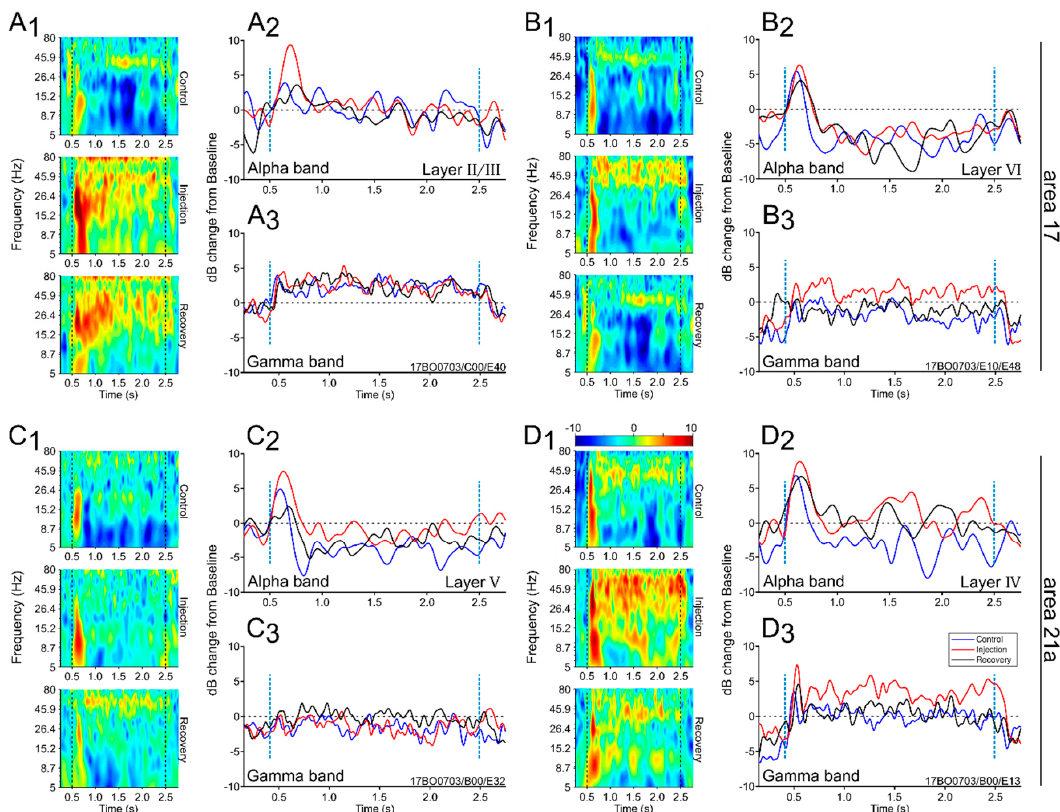
Figure 2. Oscillatory analysis for areas 17 and 21a recordings across experimental conditions. Wavelet analysis was used to calculate spectral estimates. (1) Time-frequency figures for representative samples. (2) Average time-frequency traces of alpha ranges. (3) Average time-frequency traces of gamma ranges for Ctr, Inj and Rec conditions. ( A ) Layer II/III recording from area 17. ( B ) Layer VI recording from area 17. ( C ) Layer V recording from area 21a. ( D ) Layer IV recording from area 21a.